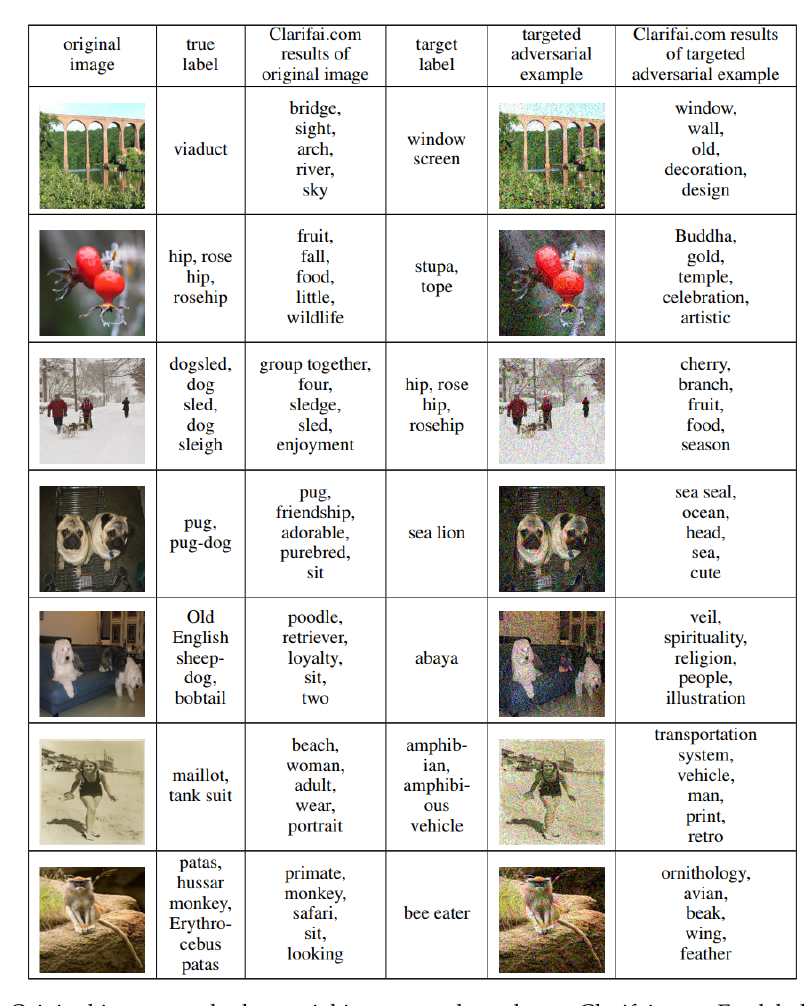
Figure 8. Original images and adversarial images evaluated over Clarifai.com. For labels returned from Clarifai.com, the authors sort the labels firstly by rareness: how many times a label appears in the Clarifai.com results for all adversarial images and original images, and secondly by confidence. Only the top five labels are provided (Image Credit: Liu et al.